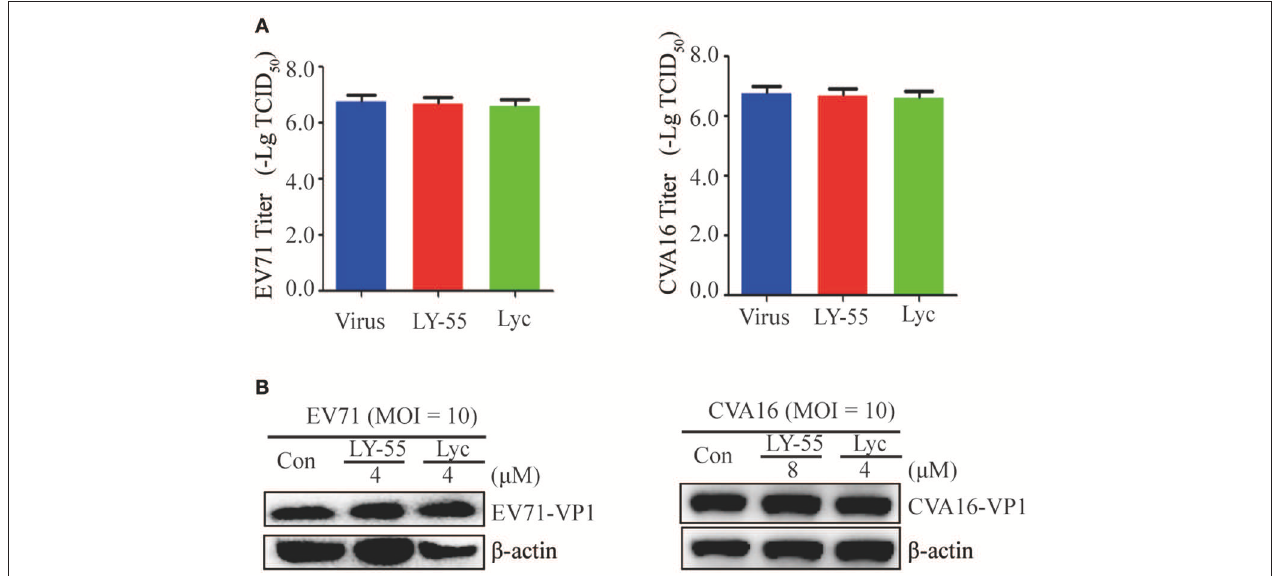
FIGURE 3 | Compound did not inactivate the virus directly. The virus with or without compounds was mixed and incubated at 37 ◦ C for 1h. Vero cells were infected with the virus after centrifugation, and viral loads were detected with titer assay (A) and Western blot assay (B) .